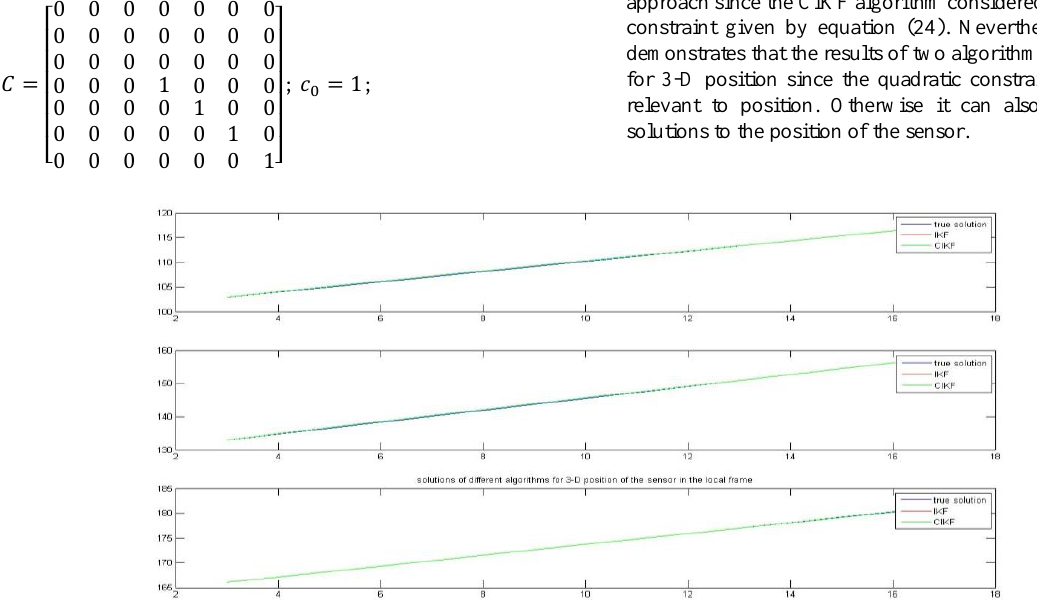
Figure 7: solutions of the CIKF and IKF algorithms for 3-D position of the mobile sensor in a local frame